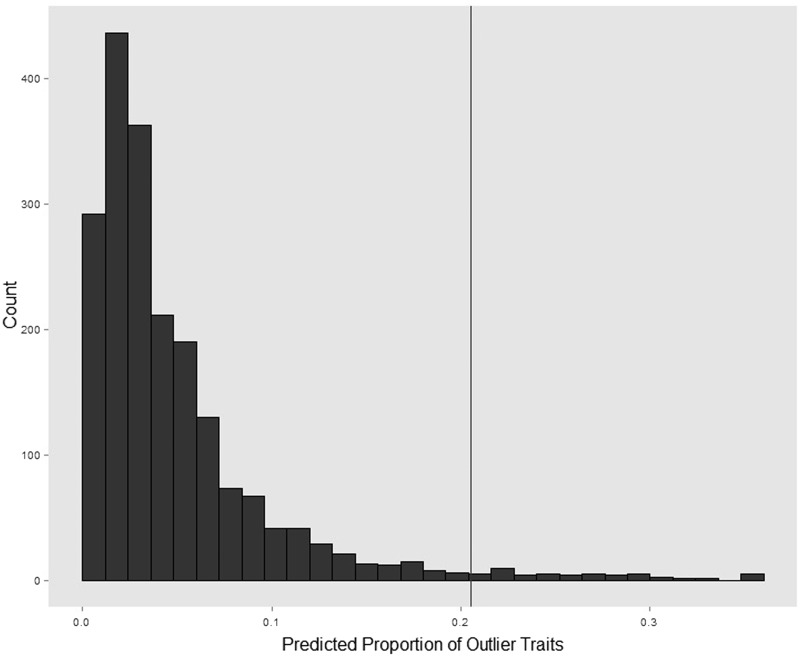
Humans have more traits identified as outliers. Posterior distribution of proportion of human traits predicted to be outliers using BayesModelS. Vertical line indicates the observed value for humans